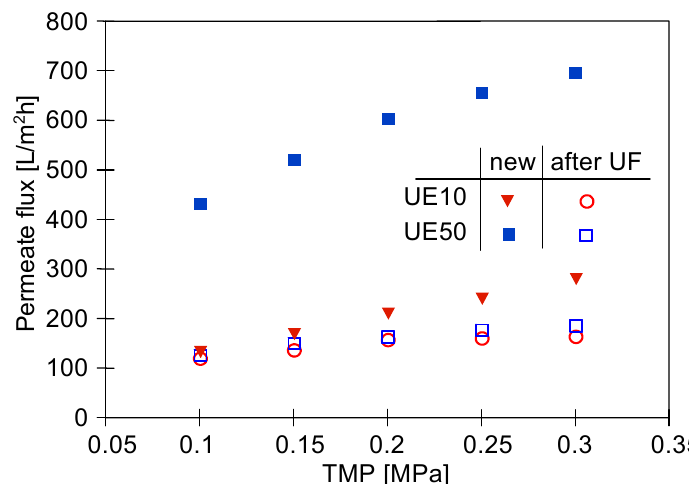
Figure 4. The impact of TMP value on the obtained permeate flux. Feed: distilled water.